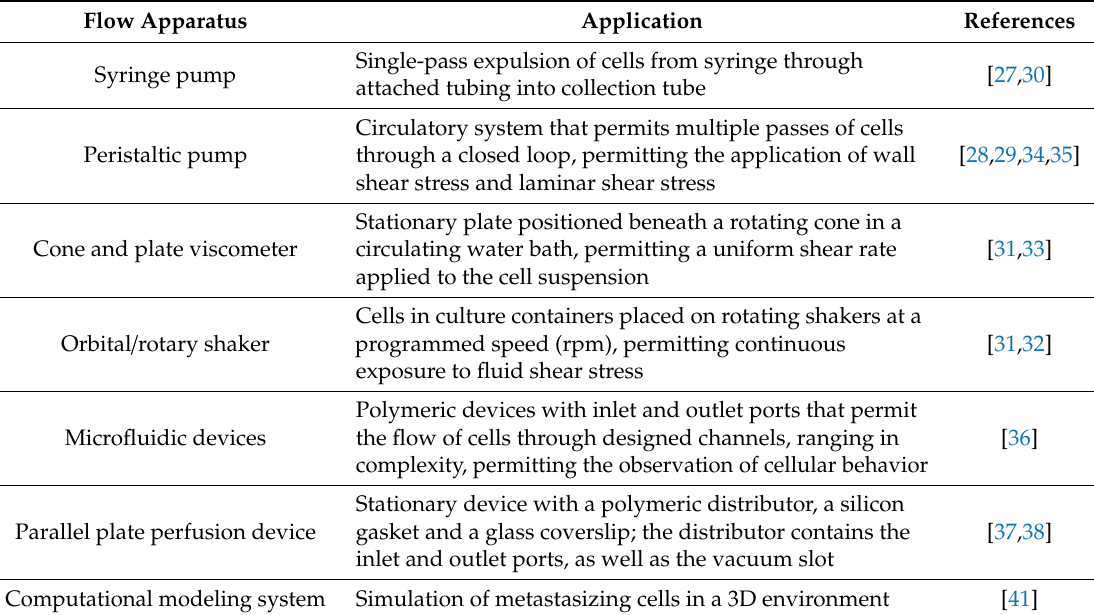
Table 1. Methods for applying fluid shear stress to cancer